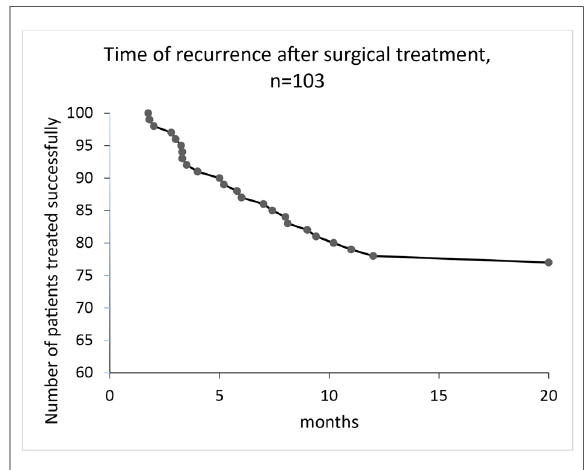
FIGURE 3 Time of recurrence after surgical treatment for perianal abscess in children, median follow-up was 22 (2 – 113)